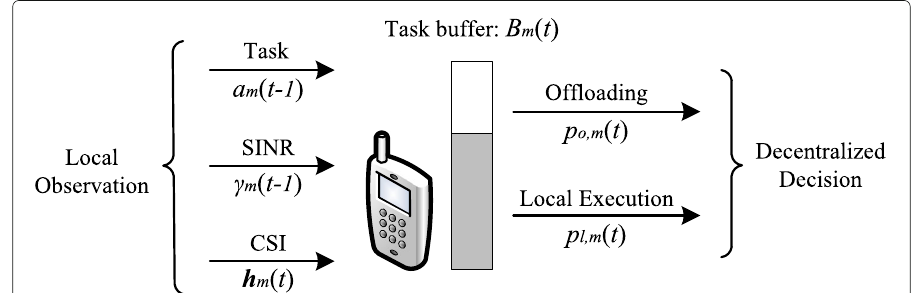
Fig. 3 Local observation and decentralized decision of user agent at slot